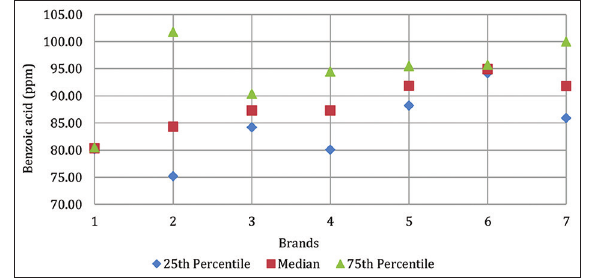
FIGURE 4: The benzoic acid content in energy drinks brands.